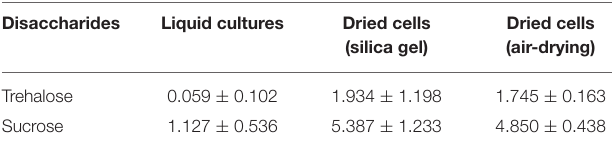
TABLE 4 | Trehalose and sucrose content in dried cells of Chroococcidiopsis sp. CCMEE 029 (mg/g dry